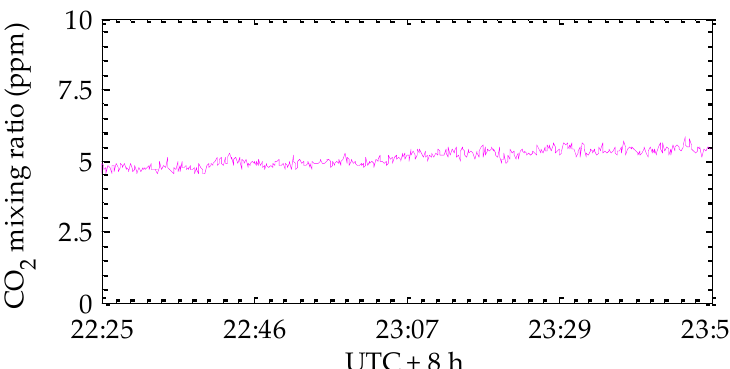
Figure 15. Normalized intensities with dual off wavelengths.